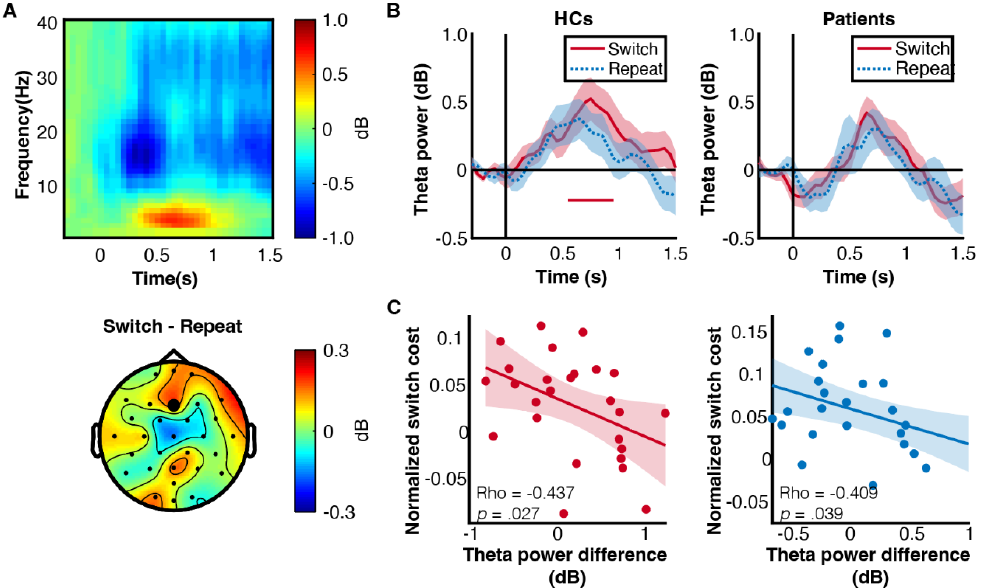
Figure 4. Frontal theta activity. ( A ) Time-frequency map of cue interval. Data was extracted from Fz and averaged across groups and conditions. The bottom panel is the topographical distribution of group averaged theta power difference between switch and repeat trials (2-7 Hz, 0.3-1 s). The black dot highlights the channel of interest. ( B ) Theta power curve of each group and each condition. The solid line below the x-axis is the significant time cluster. The shaded area is the between-subject standard error. ( C ) Spearman rank correlation between frontal theta activity and normalized switch cost. Theta activity is measured as the power difference between switch and repeat trials within the time window (0.3-1 s). Normalised switch cost is the RT difference between switch and repeat trials divided by their average. Normalisation can remove individual response speed difference. Coloured dots represent individuals’ data. The shaded area is the 95% confidence interval.